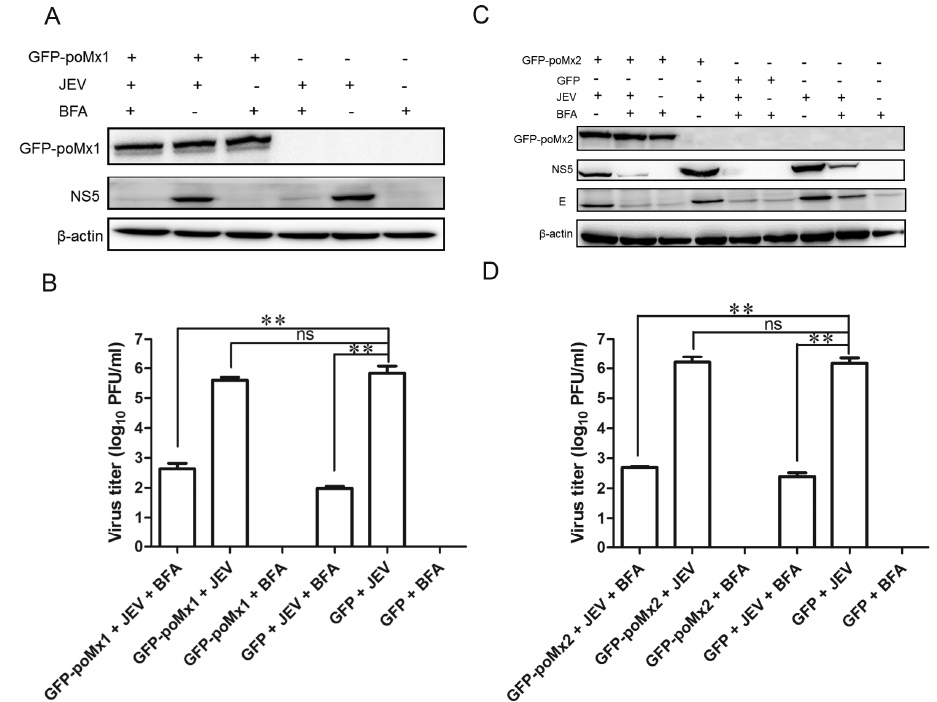
Figure 7. Mx1 or Mx2 overexpression has no impact on JEV replication in cells treated with Brefeldin A (BFA). GFP-poMx1 (or poMx2)-overexpressing BHK-21 cells and control cells were infected with JEV at an MOI of 0.05. At 12 hpi, BFA (5 µ g/mL) was added to the culture medium for an additional 12 h. The lysates of cell culture were used to determine the viral protein levels by Western blot analysis, and cell supernatants were used to determine the levels of infectious virus by plaque assay. Western blot analysis ( A ) and virus titer ( B ) of infectious virus of GFP-poMx1-overexpressing infected cells treated with or without BFA. Alternatively, Western blot analysis ( C ) and virus titer ( D ) of infectious virus of the GFP-poMx2-overexpressing infected cells treated with or without BFA. All data are presented as means ± standard deviation (S.D.) as indicated. Statistical significance is indicated as ns ( p > 0.05) and ** ( p < 0.01).